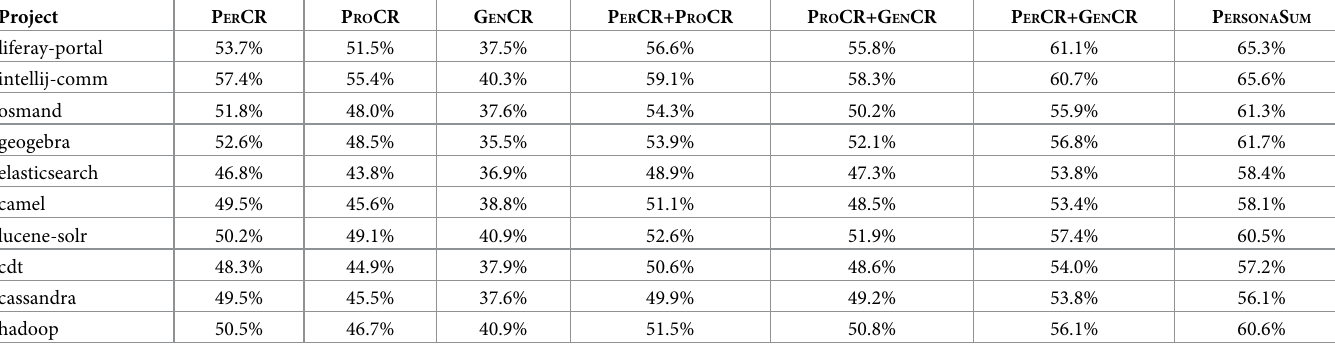
Table 7. Recommendation accuracy by removing one or two sub-models from P ERSONA .